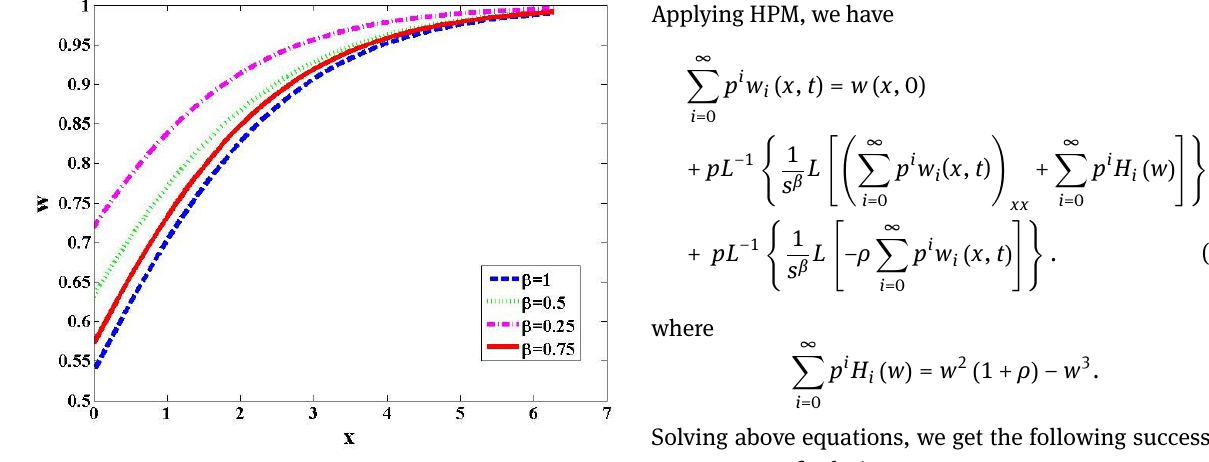
Fig. 2: Plots of w ( x , t ) w.r.t x for varying β , for Ex. 5.1